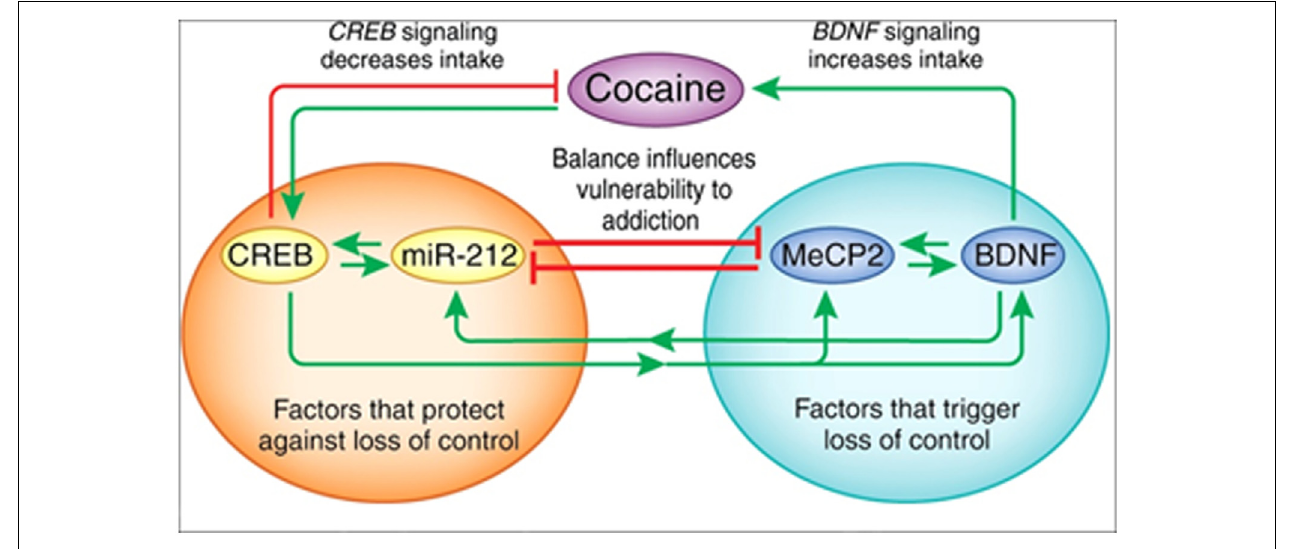
against the development of escalating cocaine intake, whereas the green circle shows that MeCP2-BDNF signaling promotes escalation of intake. Green arrows indicate a stimulatory relationship, whereas red lines indicate an inhibitory relationship. Figure and legend were taken from Jonkman and Kenny